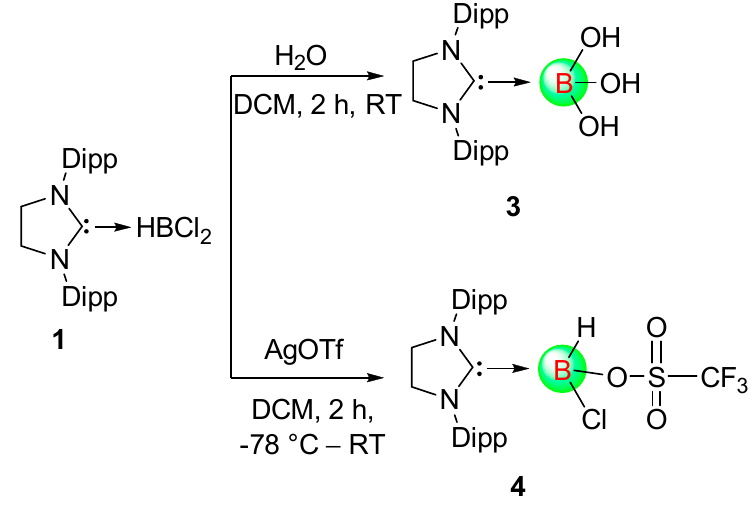
Scheme 2. Reactivity of 1 with H 2 O and